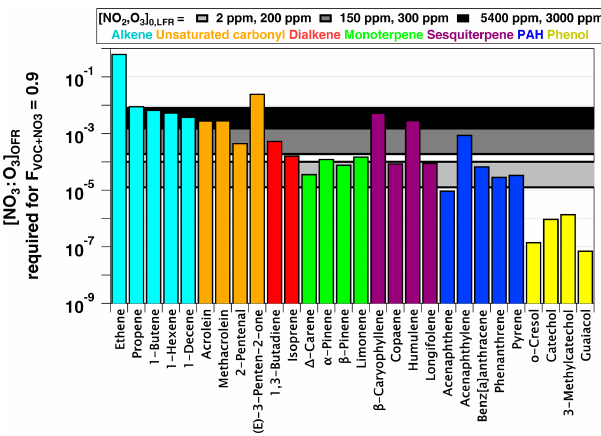
Table 1. Fit parameters for NO 3exp estimation equation (Eq.